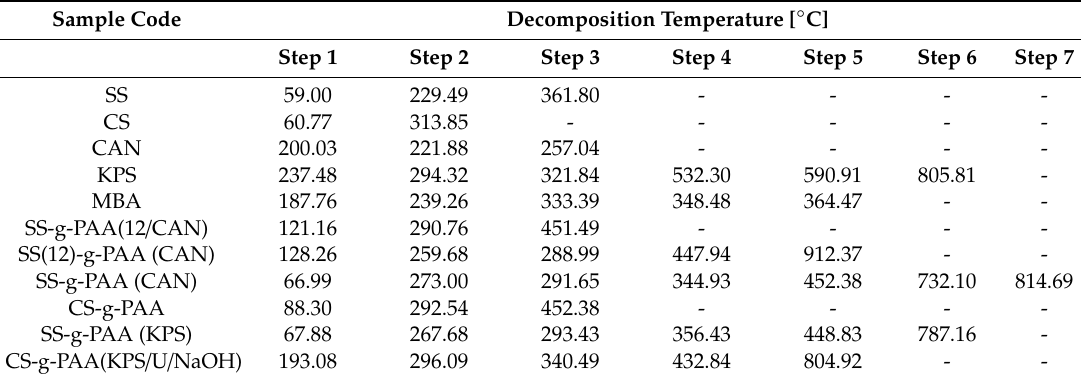
Table 3. The specific decomposition temperatures read from DTA plots of the